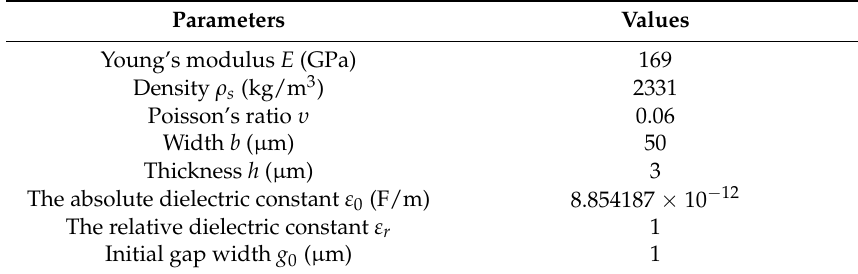
Table 3. Geometric and material parameters of a specific micro-electro-mechanical systems (MEMS) resonator [35].